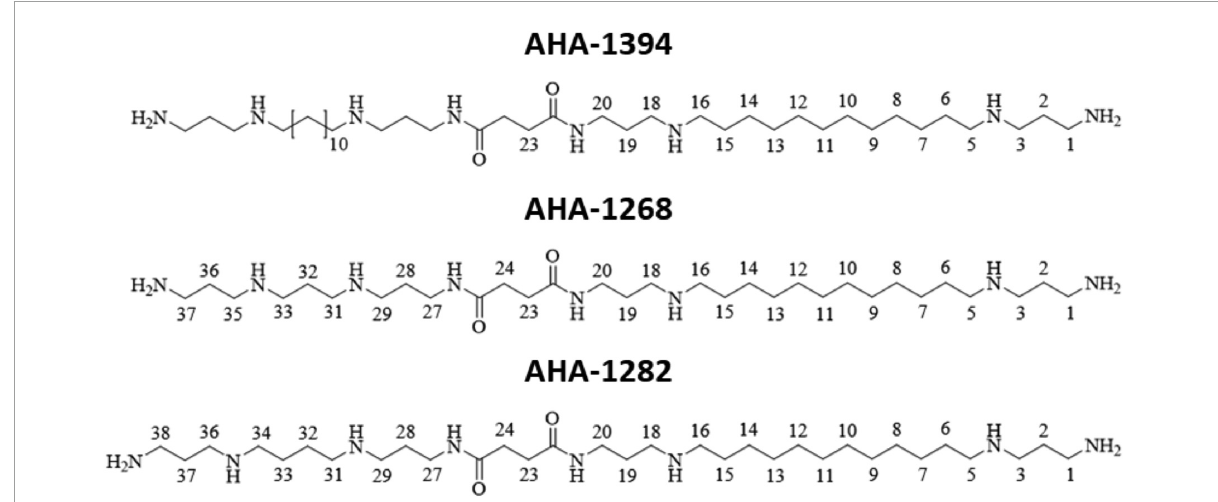
FIGURE1 Structures of novel linear polyamines with improved anti-staphylococcal activity used in this study.